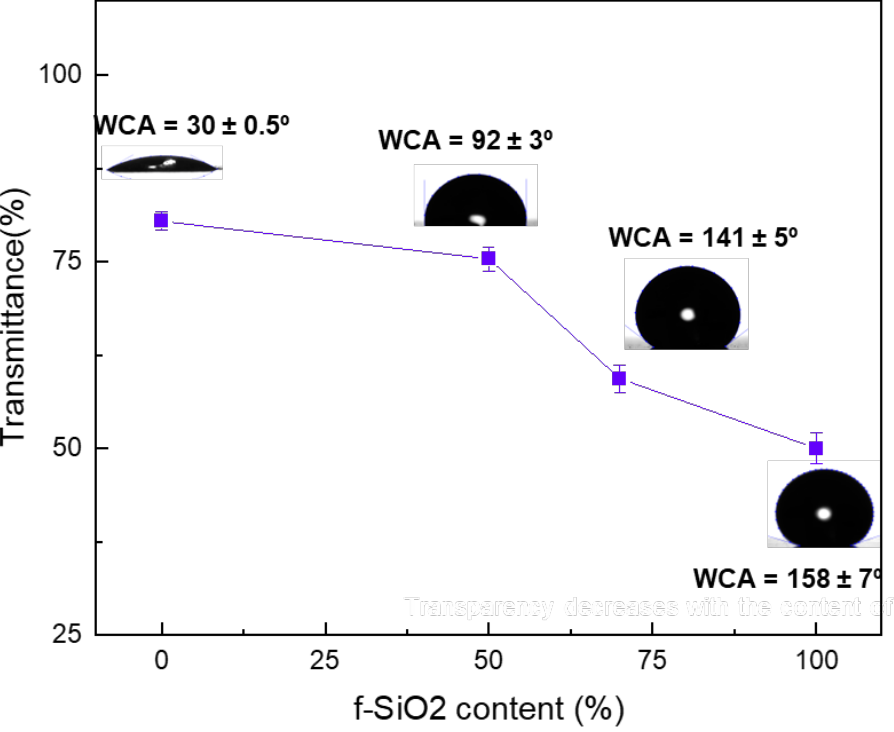
Figure 6. The value of average transmittance of the coating varies with the content of f-SiO 2 with the corresponding WCA images and values. corresponding WCA images and